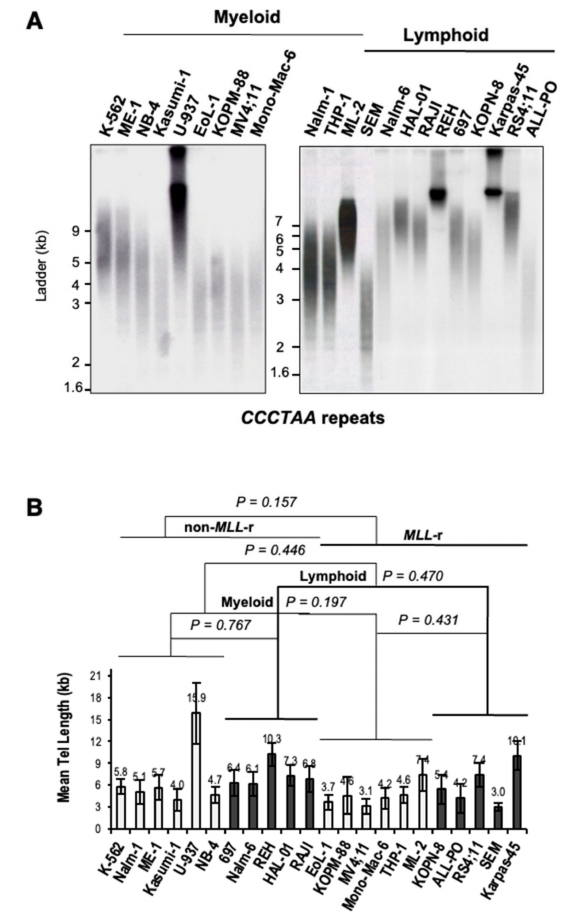
Figure 3. MLL rearrangements do not affect telomere length in leukemia. ( A ) Representative TRF analysis of myeloid and lymphoblastic leukemia cell lines carrying (or not) MLL rearrangements. Filters were hybridized with 32 P-end-labeled 5 (cid:48) -(TTAGGG) 4 -3 (cid:48) oligonucleotide complementary to the telomeric leading-strand CCCTAA repeats. ( B ) Telomere length analysis of myeloid and lymphoblas- tic leukemia cell lines. The duplex-repeat signal intensity was measured by densitometry analysis, and the mean telomere length (MTL) was calculated using Telometric software (see Materials and Methods). MTL value (kb) and standard deviation bars are indicated. We calculated the p -value by two-way ANOVA